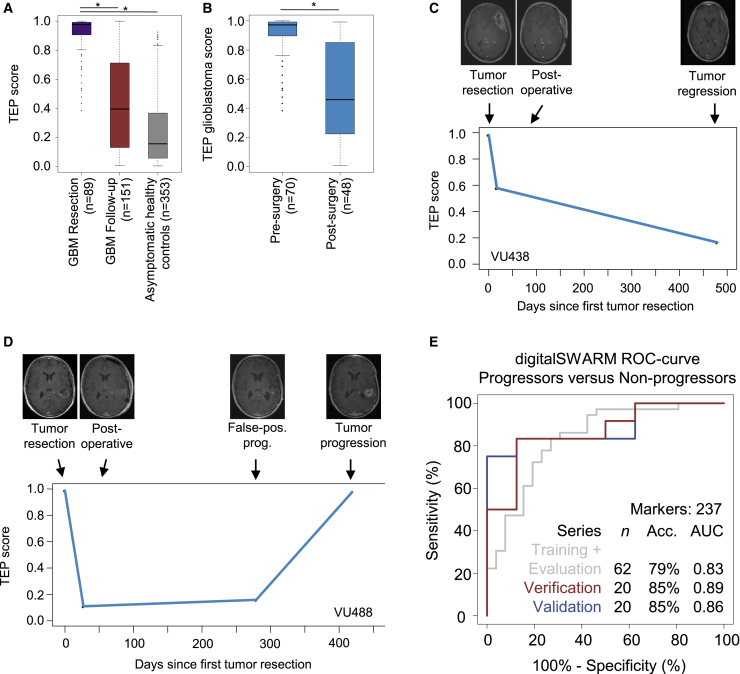
TEP RNA Signatures for Glioblastoma Therapy Monitoring and (False Positive) Progression Analysis(A) Boxplot of the TEP score (classification strength as output by the thromboSeq software) of glioblastoma at the moment of first tumor resection (n = 89), glioblastoma follow-up (n = 151), and asymptomatic healthy control (n = 353) samples classified in the “glioblastoma versus asymptomatic healthy controls” algorithm. Classification of glioblastoma follow-up samples (n = 151) results in significantly reduced TEP scores compared with glioblastoma samples collected at the moment of first tumor resection (n = 89). Per boxplot, the median, IQR, and 1.5 × IQR (whiskers) are shown.(B) Boxplot of the TEP score before and at the first time point after tumor resection (pre-surgery, n = 70; post-surgery, n = 48), indicating reduced TEP scores following (partial) tumor removal. Per boxplot, the median, IQR, and 1.5 × IQR (whiskers) are shown.(C and D) TEP score plotted during the therapy course, indicated as days since primary tumor resection, for patients VU438 (C) and VU488 (D), connected by a straight line. The MRI images acquired at each time point are shown at the top of the graph. Radiological evaluation of tumor growth is indicated below each MRI image.(E) ROC curve of the “progressive versus non-progressive” digitalSWARM classifier, including the combined training plus evaluation series (gray), verification series (red), and validation series (blue). Indicated are sample series sizes, best accuracy, and AUC value.See also Figure S2 and S3 and Table S2F.